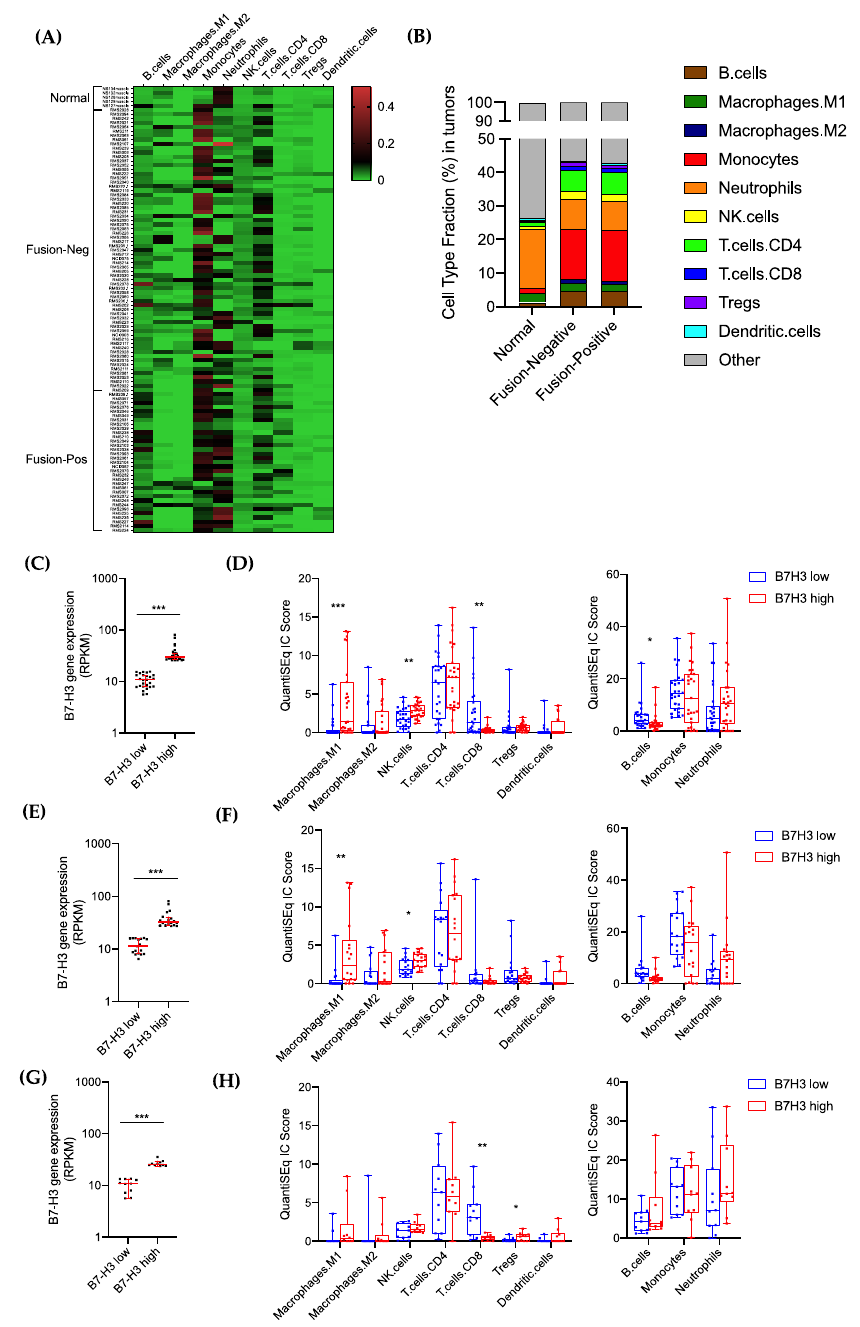
Figure 5. Relationship of B7-H3 expression and tumor-infiltrating immune cells in RMS. ( A ) Heatmap of immune cell abundance estimated by QuantiSeq analysis in normal muscle, fusion-negative and fusion-positive RMS. ( B ) Mean percentages of different immune cell subsets in normal muscle, fusion-negative and fusion-positive RMS. ( C , E , G ) B7-H3 RNA expression in quartile subgroups (25% highest, 25% lowest) in RMS tumors ( C ), FN-RMS ( E ) and FP-RMS ( G ) used for immune cell abundance analysis. ( D , F , H ) Bar graphs showing immune cell abundance between B7-H3-low and B7-H3-rich RMS tumors ( D ), FN-RMS only ( F ) and FP-RMS only ( H ). Significance is denoted by asterisks (*** p < 0.001; ** p < 0.01; * p < 0.05; Student’s t